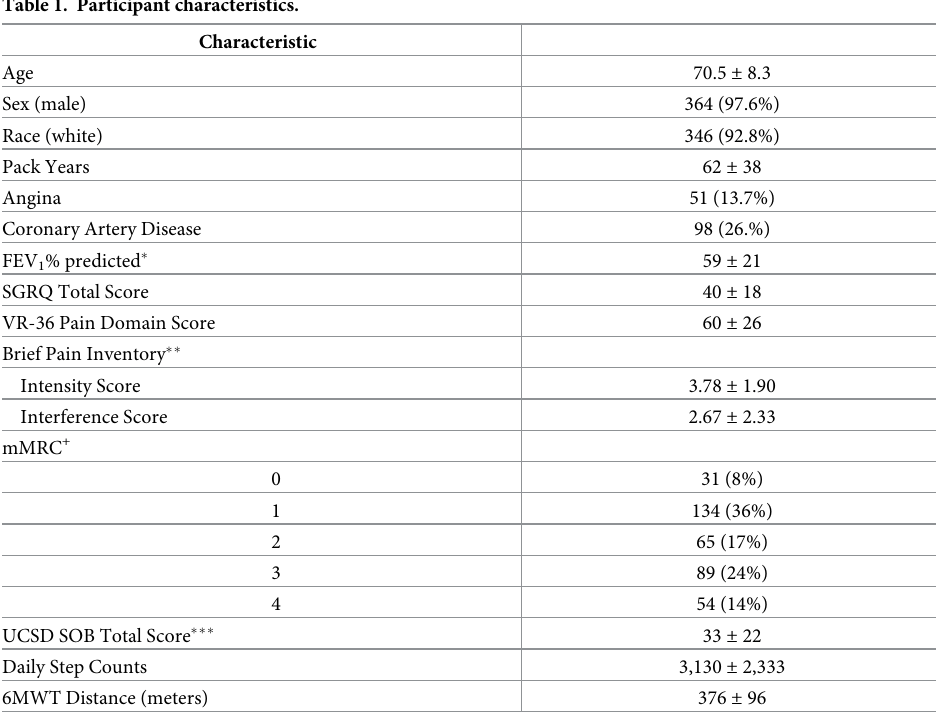
Table 1. Participant characteristics.